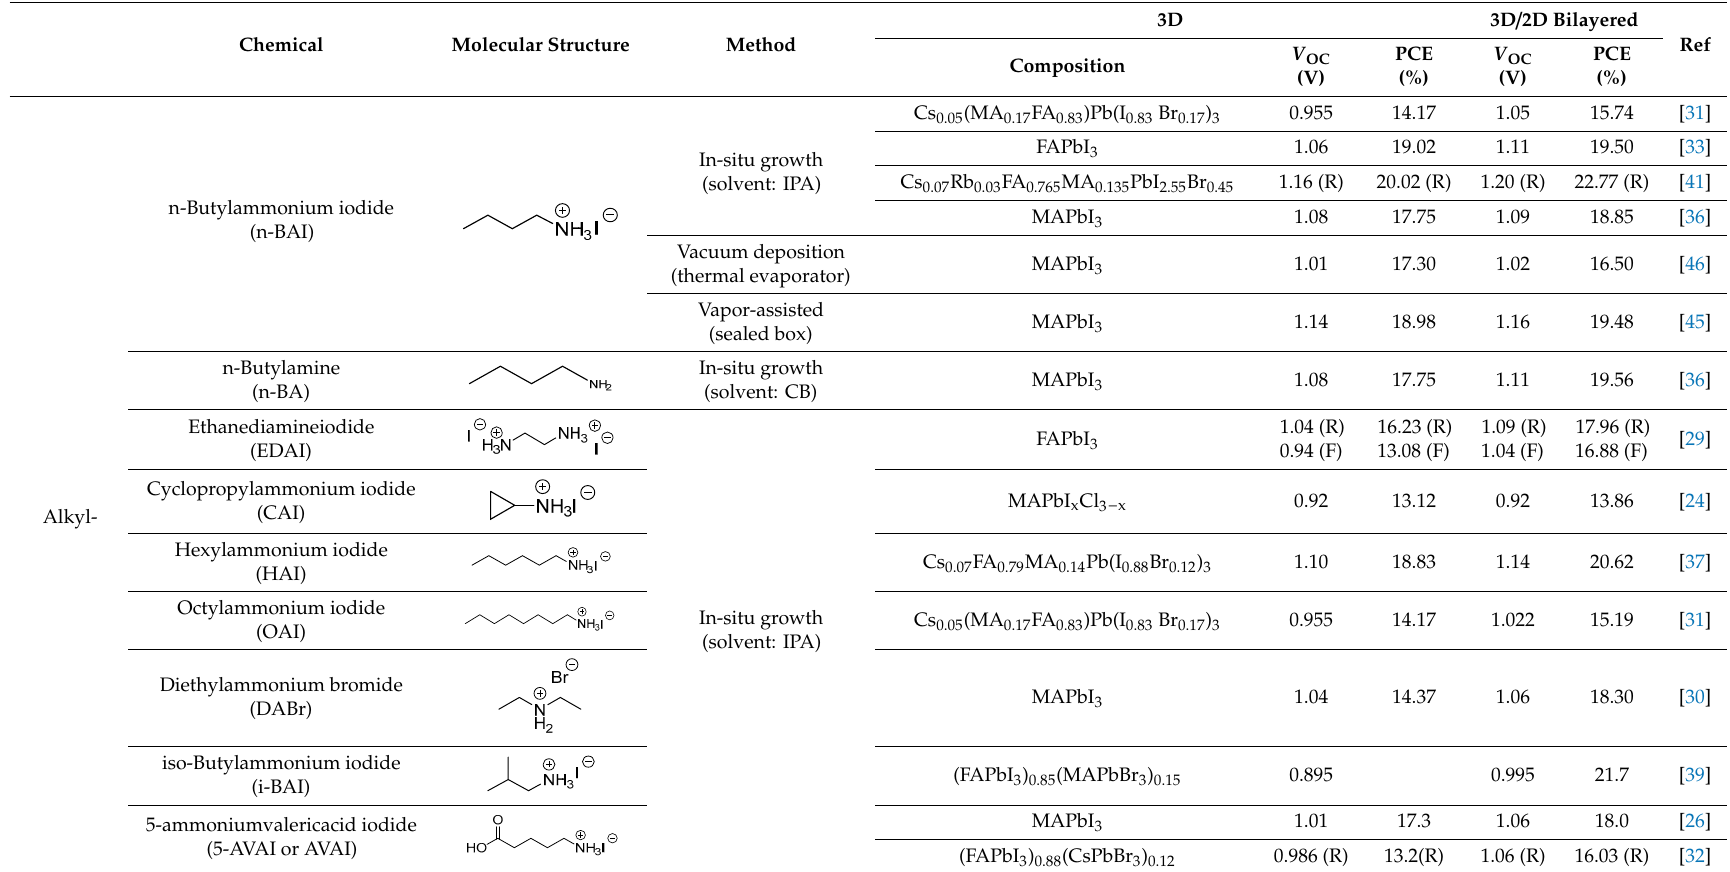
Table 1. Organic salts employed for 2D layer formation.